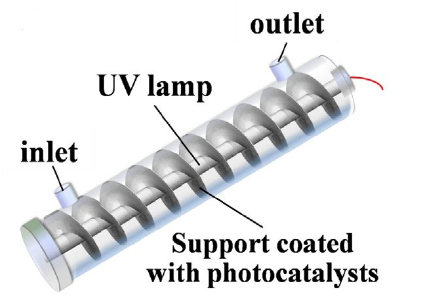
Figure 21. Photocatalyst coated, helical structure by Yu et al. for water purification. (Reprinted/adapted with permission from Ref. [89]).